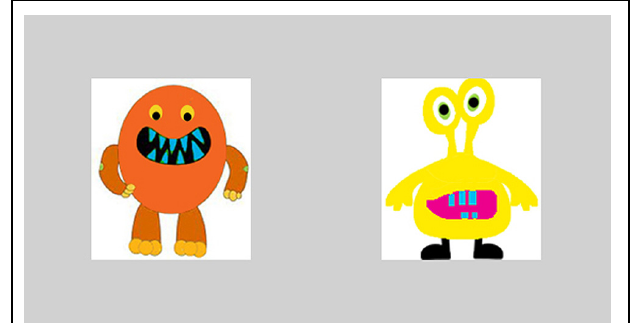
FIGURE 1 | Sample visual